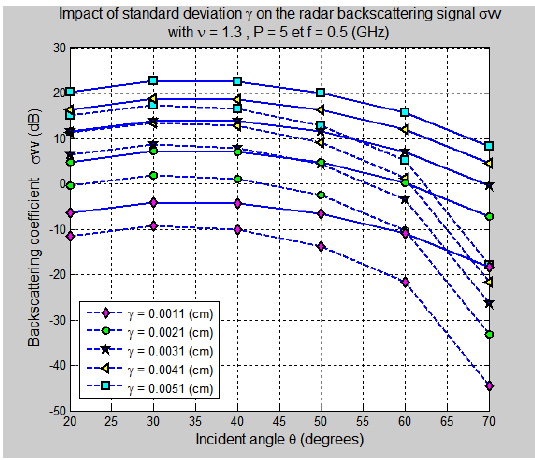
Figure 6: Backscattering coefficient dependence on 𝛄 , parameter related to the Root Mean Square at VV polarization for bare soil (dashed line) and for vegetated soil (full line)